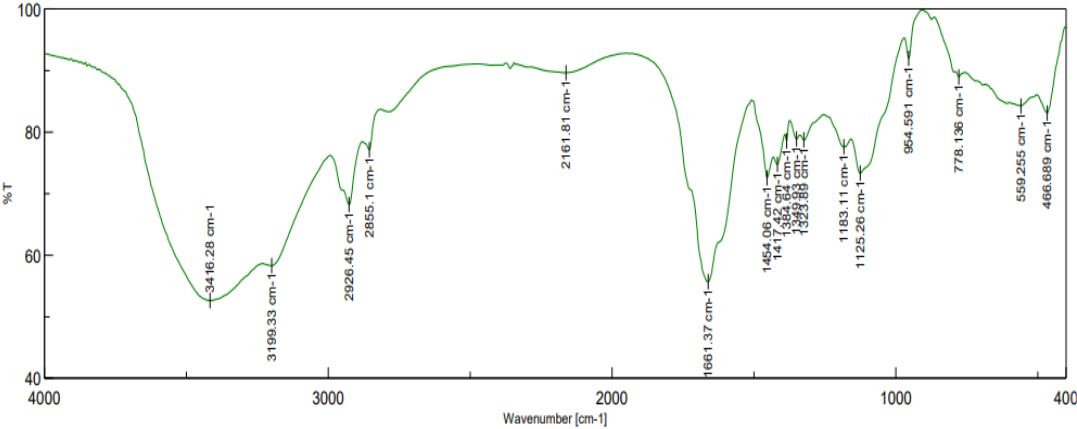
Figure 4. FTIR spectra of CPAM copolymers.